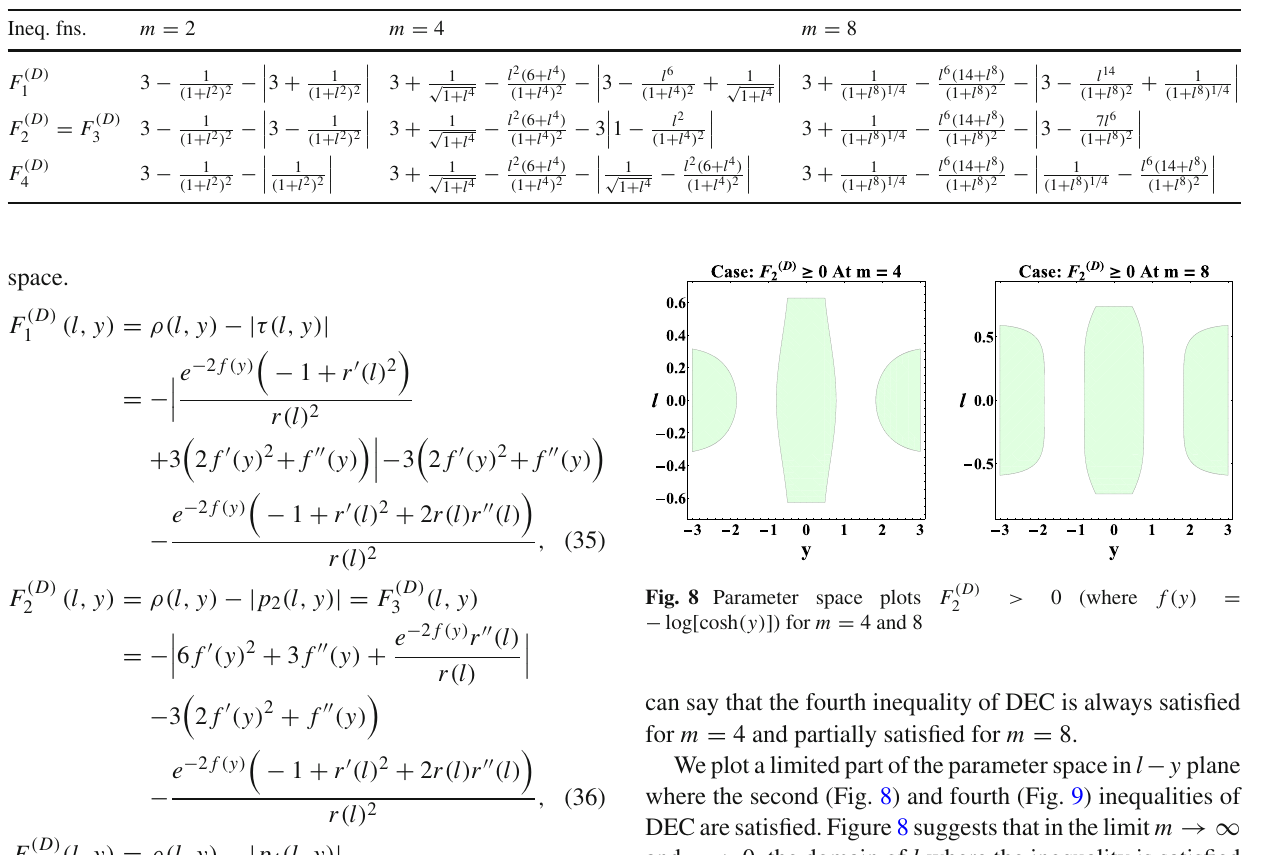
can say that the fourth inequality of DEC is always satisfied for m = 4 and partially satisfied for m = 8. We plot a limited part of the parameter space in l − y plane where the second (Fig. 8) and fourth (Fig. 9) inequalities of DEC are satisfied. Figure 8 suggests that in the limit m → ∞ and y → 0, the domain of l where the inequality is satisfied